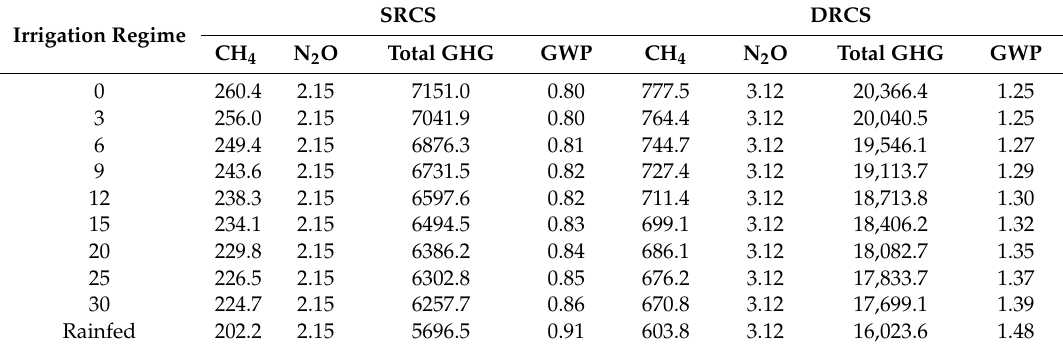
Table 9. CH 4 and N 2 O emissions (kg ha − 1 y − 1 ), total GWP (kg CO 2 -eq ha − 1 y − 1 ), and mean GWP (kg CO 2 -eq GY − 1 ) under di ff erent irrigation regimes and rainfed condition for SRCS and DRCS during